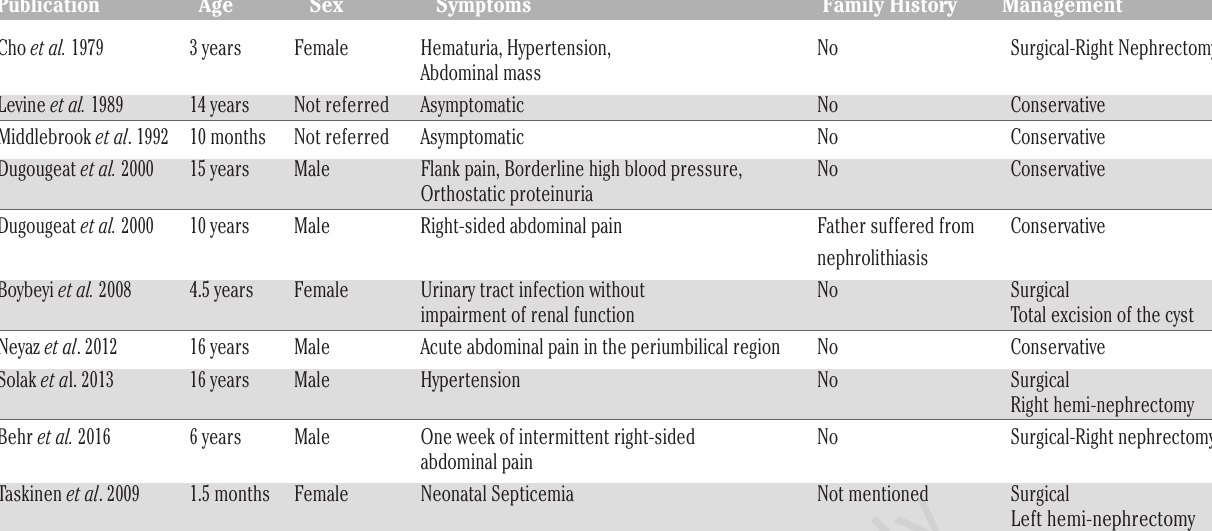
Table 1. Literature results of pediatric patients with localized cystic disease of the